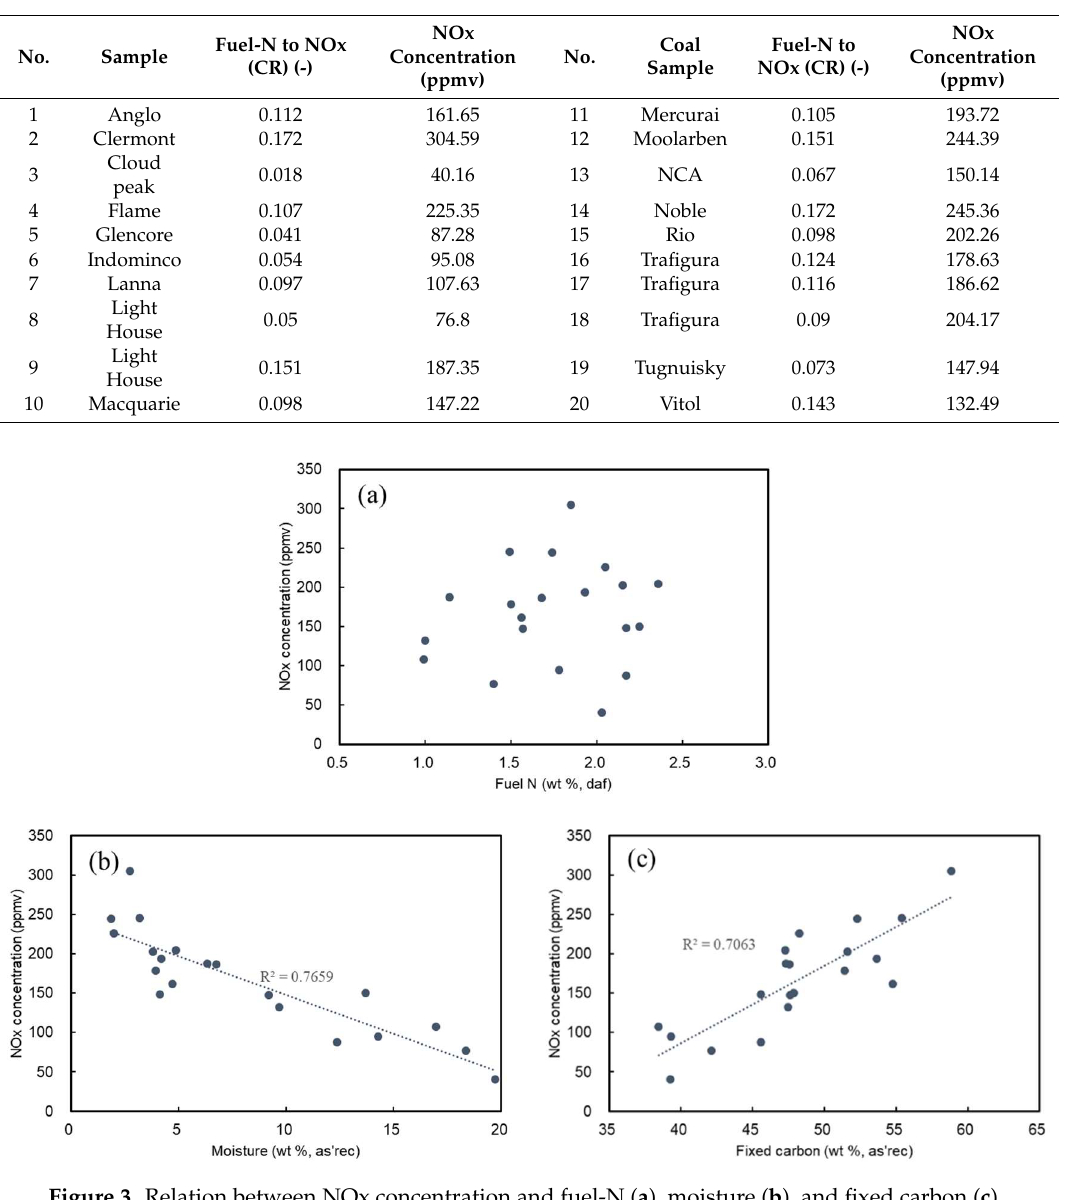
Table 2. Fuel-N to NOx values and DTF NOx concentration at the exit.